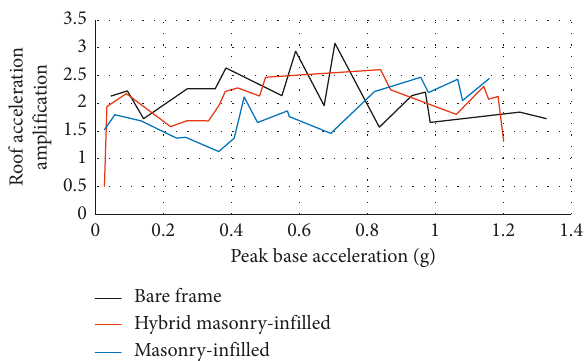
Figure 13: Acceleration amplification of structures correlated with input excitation peak acceleration. The values are those for the reduced scale test